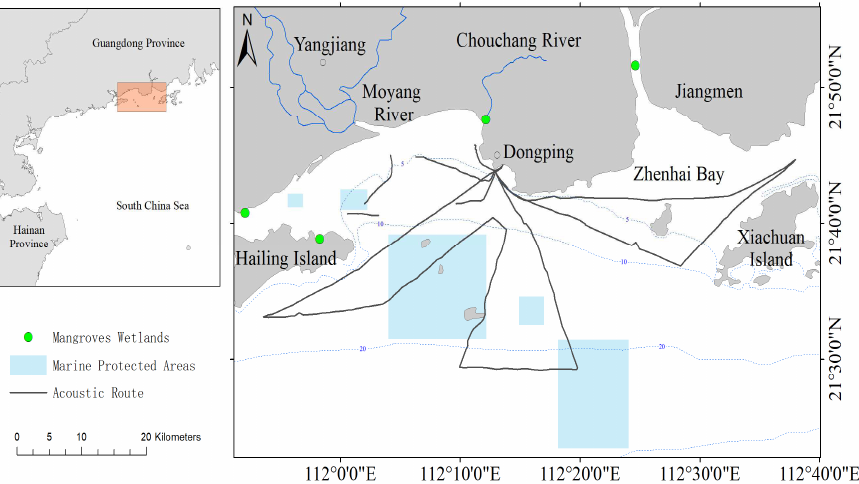
Figure 1. Location of the study area, which was highlighted in orange. These light blue areas are marine protected areas, and the green points represent mangrove wetlands.